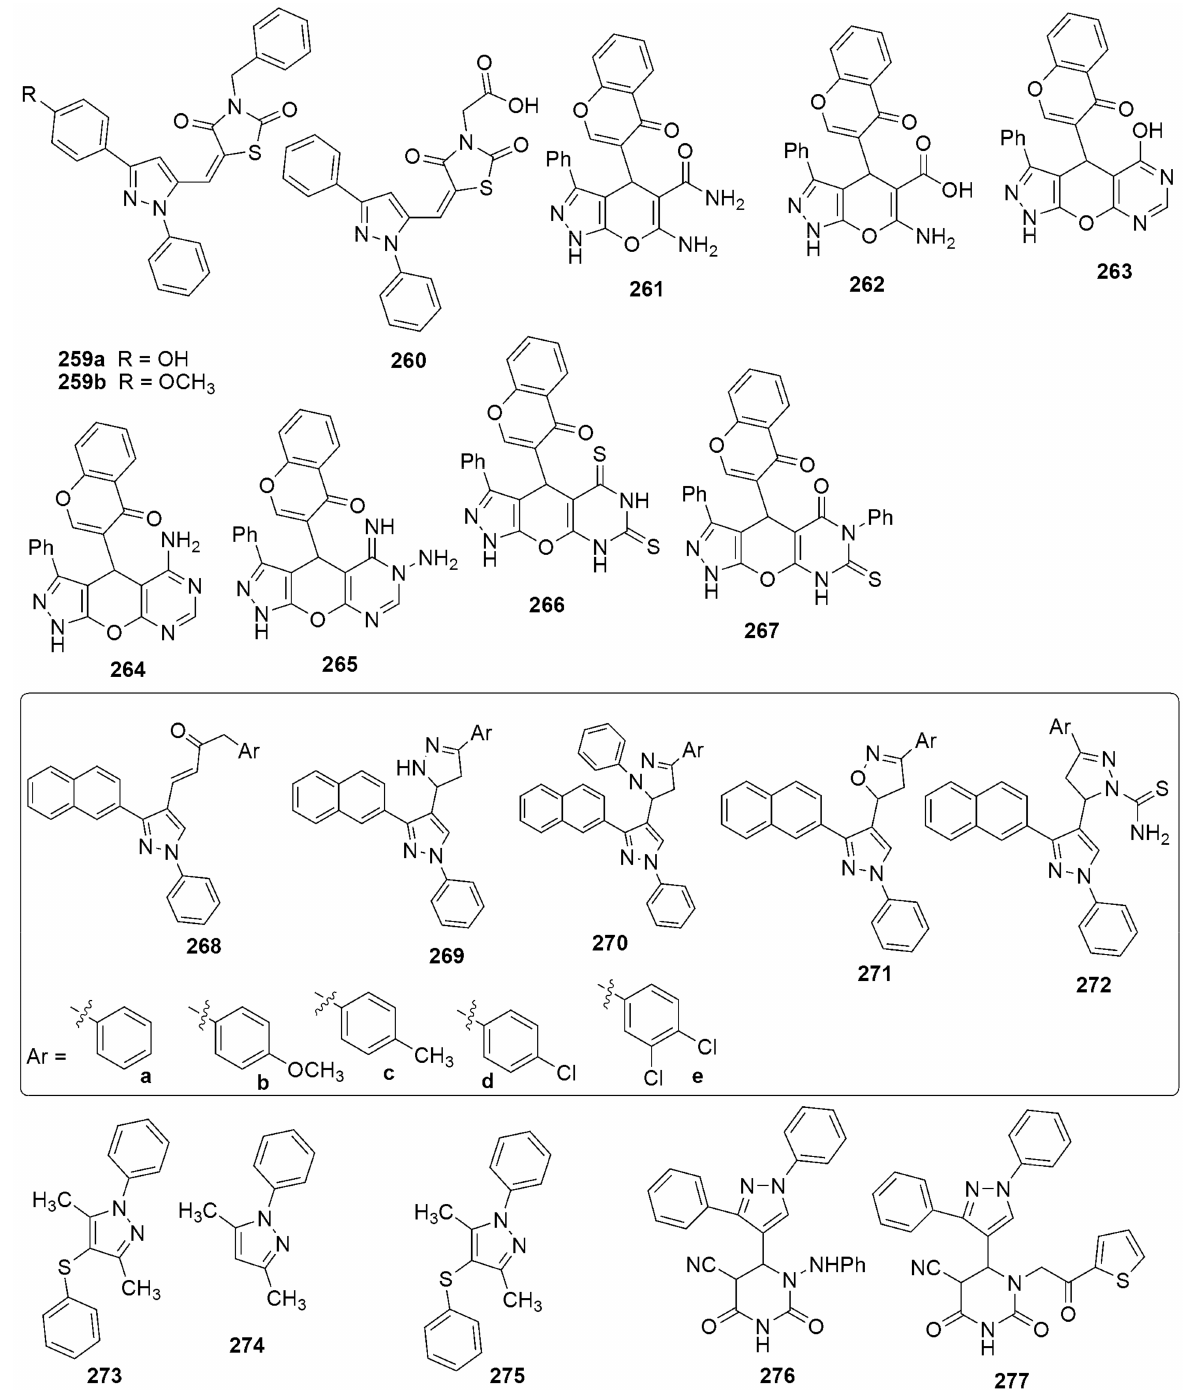
Figure 15. Structures of promising pyrazole derivatives with antioxidant